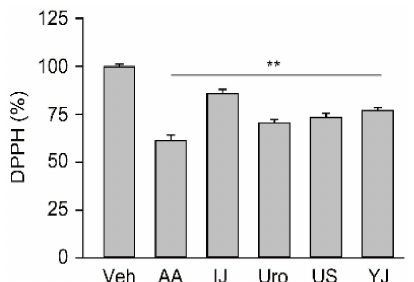
Figure 1. Free radical scavenging activity of polyherbs. Antioxidant activity of four polyherbs, IJ, Uro, US, and YJ, was assessed using the 1,1-diphenyl-2-picrylhydrazyl (DPPH) assay. Ascorbic acid (AA) was used as a positive control. The results were compared with the vehicle control (Veh), and were expressed as a percentage of the control. Values are means ± standard deviation (SD) from three independent experiments. **: p < 0.01 versus the Veh group.